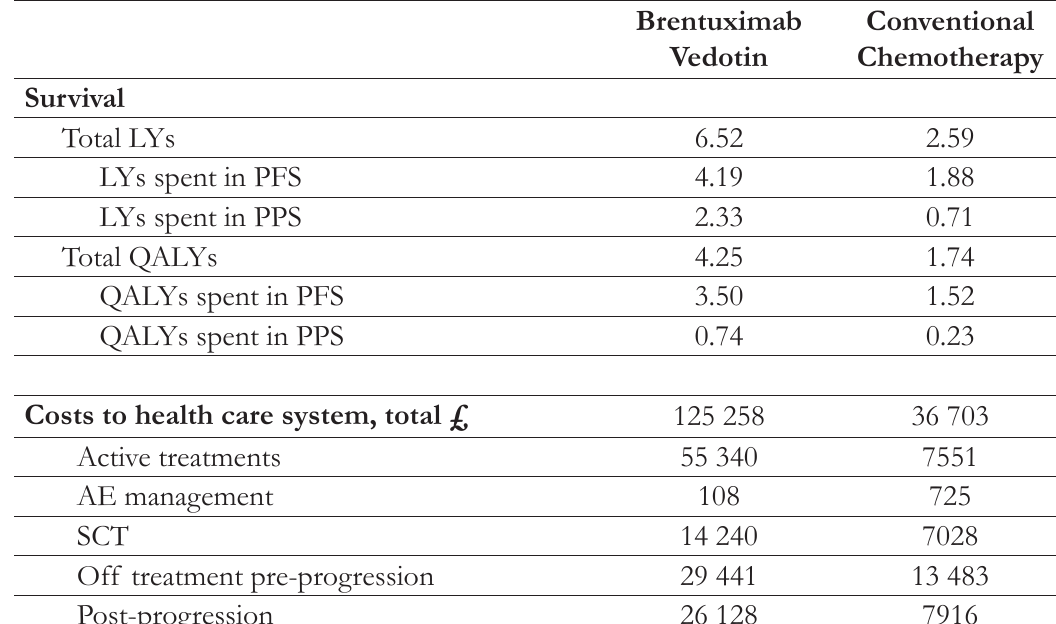
Table 2. Discounted LYs, QALYs and Costs by Resource Category